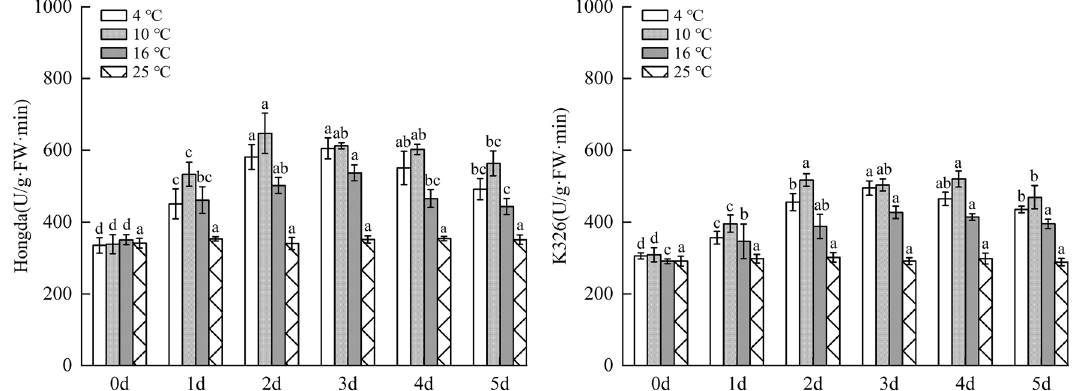
Figure 12. The changes of CAT activity in tobacco leaves under different low-temperature stresses. Different lowercase letters indicated that there were significant differences at different times under the same temperature treatment (P < 0.05).The values were the mean of three biological replicates.